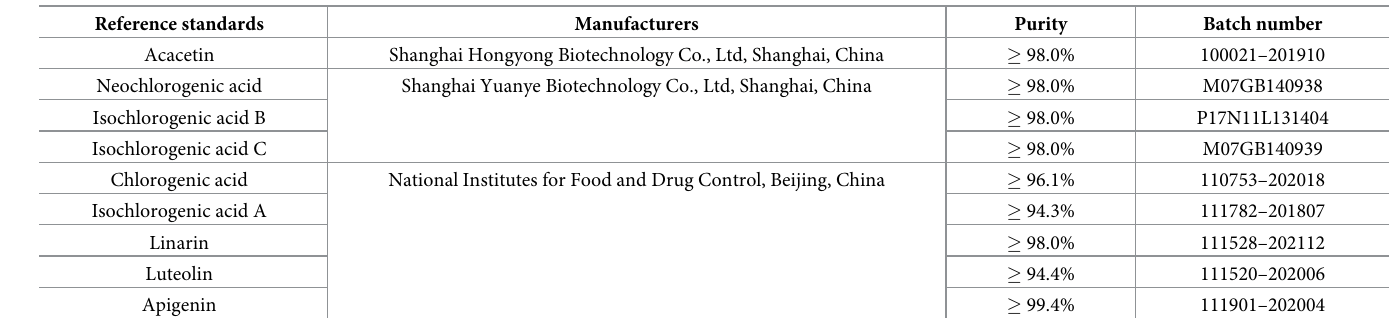
Table 2. Manufacturer and batch number of reference